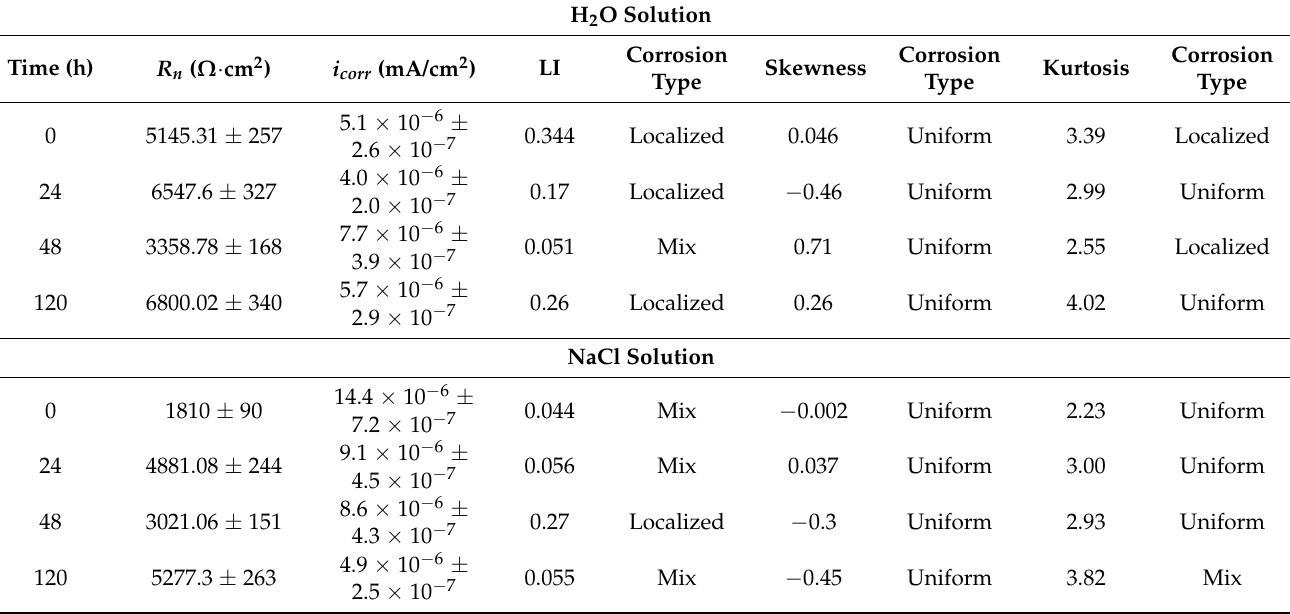
Table 4. EN statistical parameters from Al-A.M. alloys and